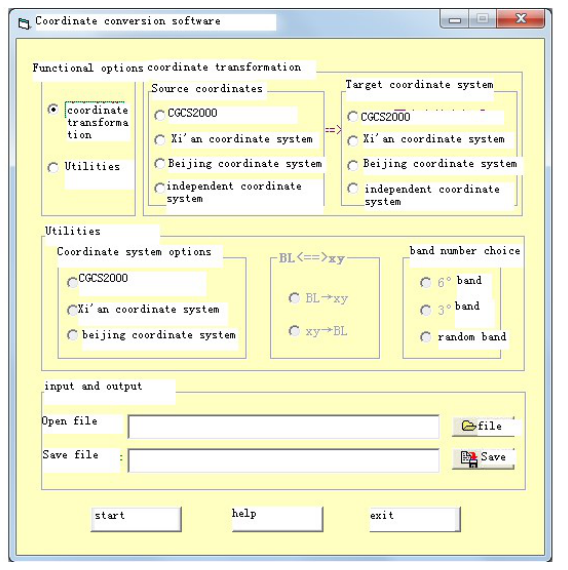
Fig. 2 Software for coordinate transformation of urban independent coordinate system of Bijie central